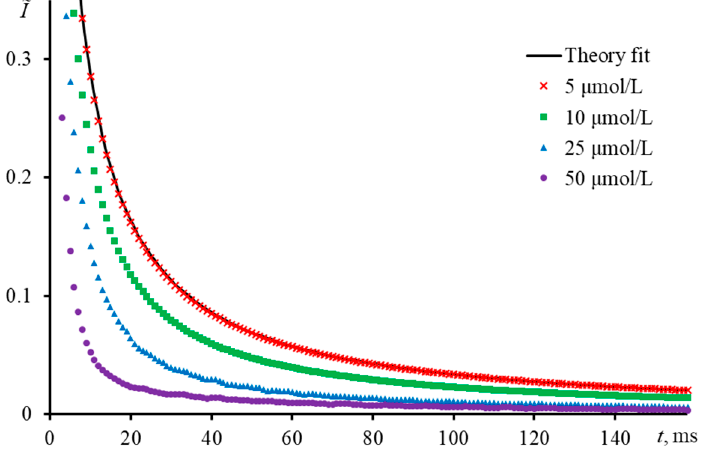
Figure 13. Normalized transient curves of aqueous solutions of ferroin with different concentration; narrow-focused configuration ( 𝜔 (cid:3032)(cid:2868) = 33 µm, Figure 1, Table 3).